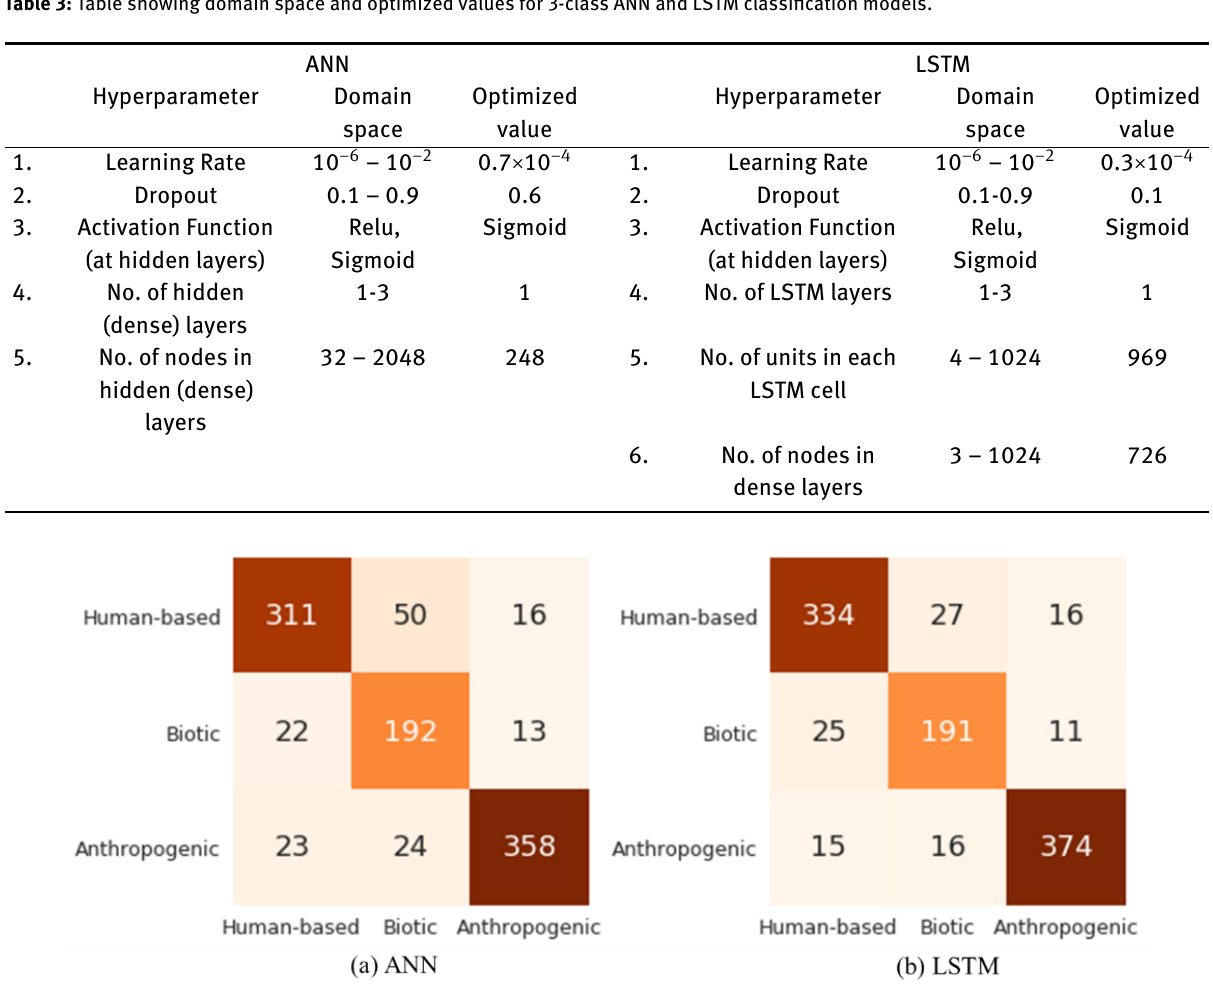
Table 3: Table showing domain space and optimized values for 3-class ANN and LSTM classification models.